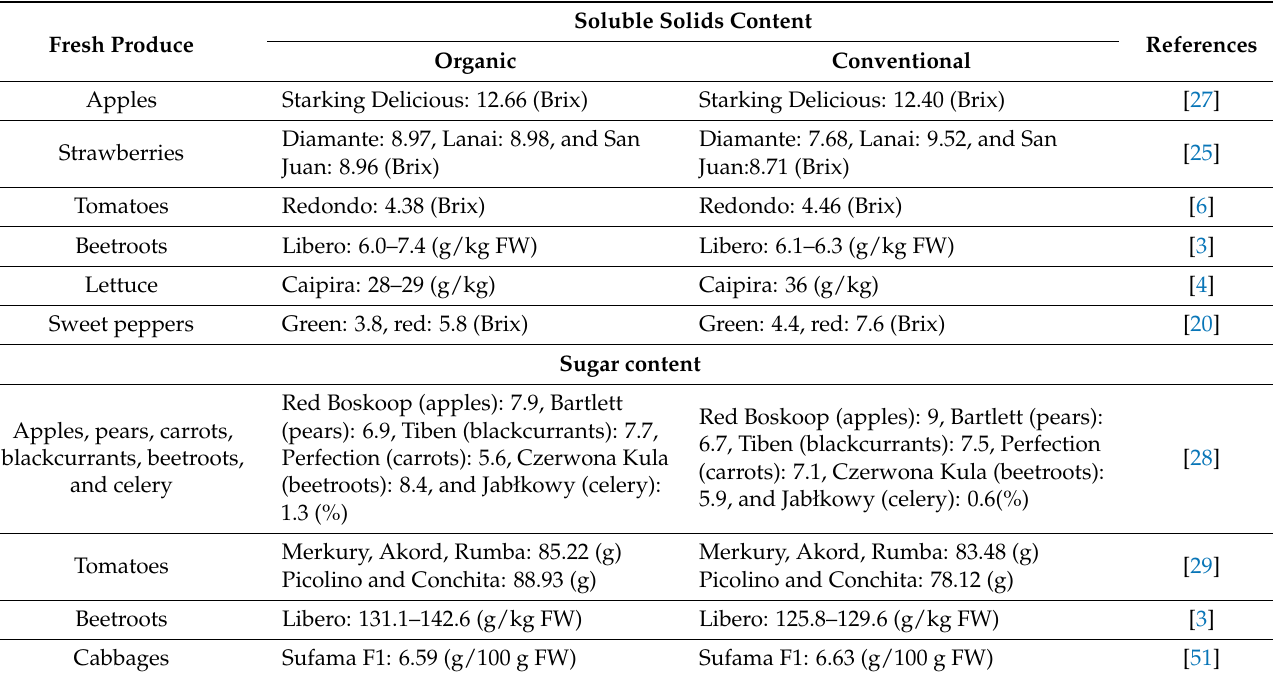
Table 6. Soluble solids and sugar content of organic and conventional fresh